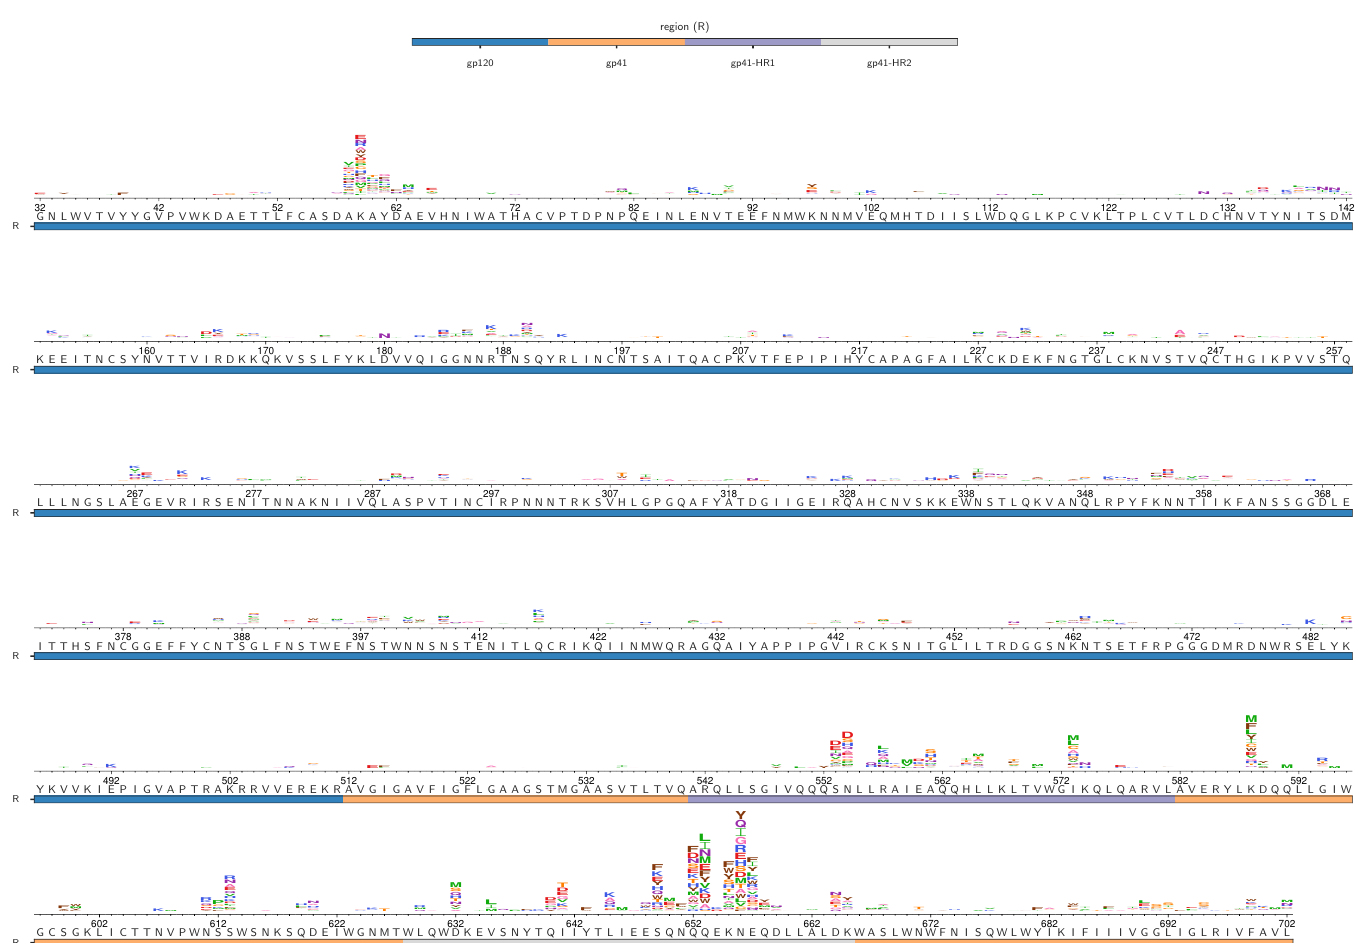
Figure 2. S mut / wt values of amino acids enriched during 293T rhm infection. BF520 Env wild-type amino acid identities are shown below the axes for residues 32–702. Logoplots above the axes indicate mutants that were enriched relative to wild-type residues (S mut / wt > 0) following infection of 293T rhm cells in our DMS. The height of each letter is proportional to the S mut / wt value for that amino acid mutant following 293T rhm infection, averaged over both replicate infections. Site numbers correspond to HXB2 numbering. The underlay bar indicates Env